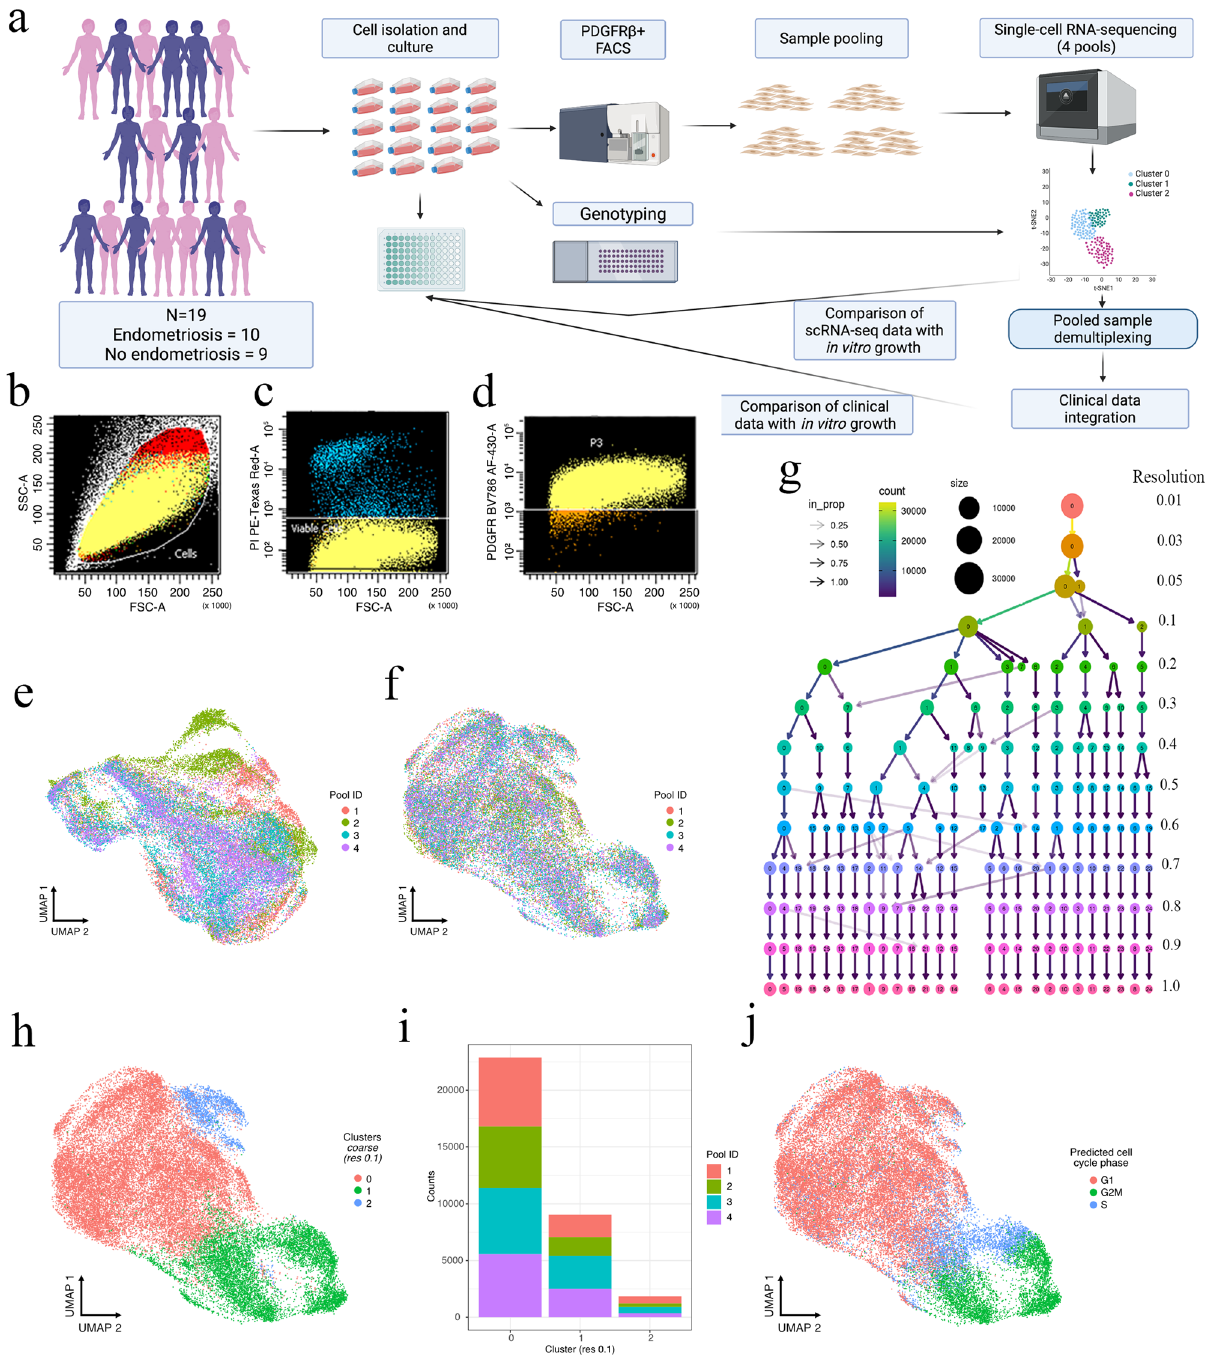
Fig. 1 Experimental design and quality control for high throughput single-cell RNA sequencing of puri fi ed endometrial mesenchymal cells. a Endometrial biopsies were isolated, from 19 different women and cultured. In vitro growth assays, DNA isolation for genotyping and PDGFR β + FACS puri fi cation was performed. Puri fi ed cells from nineteen samples were pooled into four lanes and run on the 10X Chromium controller and scRNA-seq data was analysed and cell clustering was performed. Samples were assigned to their source individual and clusters compared to clinical data. Both scRNA-seq data and clinical data were compared to in vitro growth. Mesenchymal stromal cells were puri fi ed via FACS ( b ) forward and side scatter, c viability and d PDGFR β + expression. UMAP plot distribution of scRNA-seq data was determined both e pre- and f post harmony correction of between-pool variations introduced through technical variations. g Clustree analysis was used to determine the most stable level for cellular clustering. h UMAP plot of integrated scRNA-seq data at a clustering resolution of 0.1 identi fi ed three distinct clusters with minimal subsequent mixing at a fi ner resolution. i At a cluster resolution of 0.1, cell numbers from each pool in each cluster remained stable suggesting clusters were formed from biological differences rather than technical effects. j UMAP plot of scRNA-seq data labelled by cell cycle phase inferred by the CellCycleScoring function in Seurat. a Created with BioRender.com.